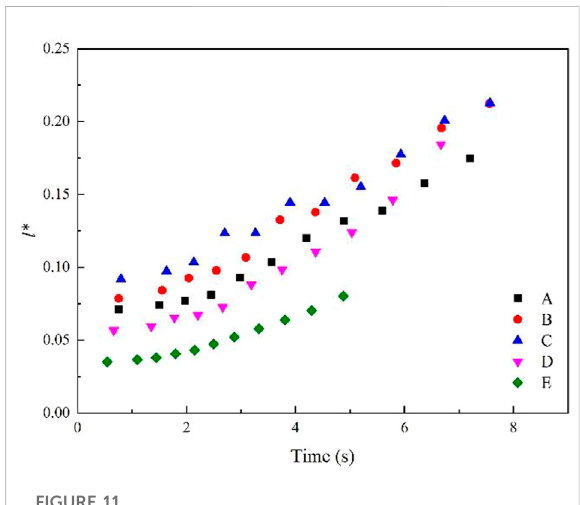
FIGURE 11 Inertial length with different properties of